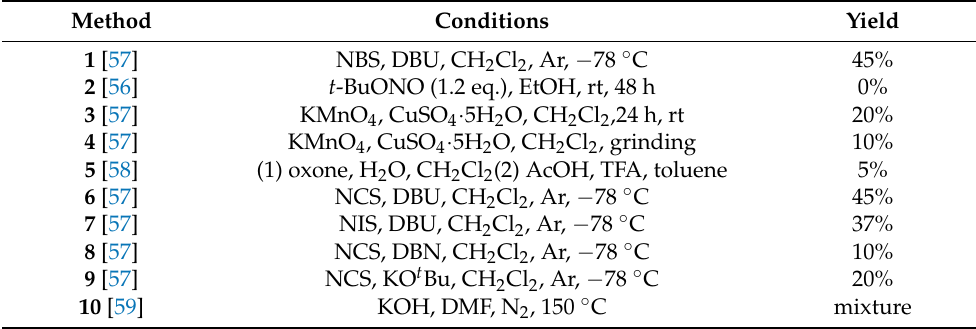
Table 2. Screening of reaction